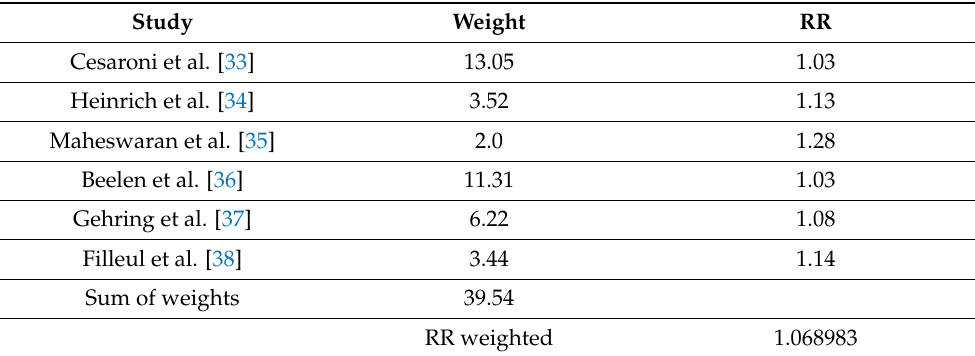
Table 4. Relative risks of natural mortality with increasing chronic exposure to NO 2 by 10 µ g/m 3 . Meta-analysis of European studies (from Faustini et al. (2014)